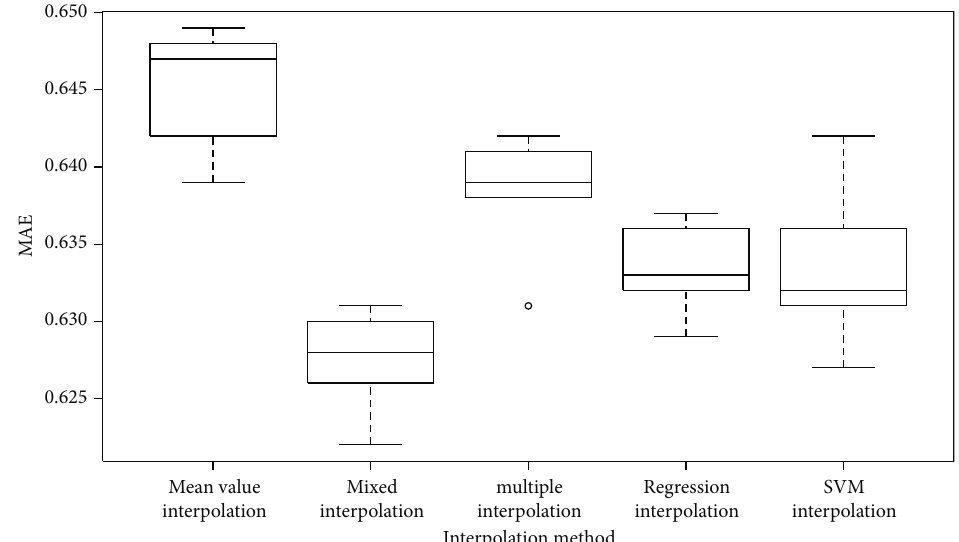
Figure 5: Boxplot of MAE values of five interpolation methods under 5% data miss rate.